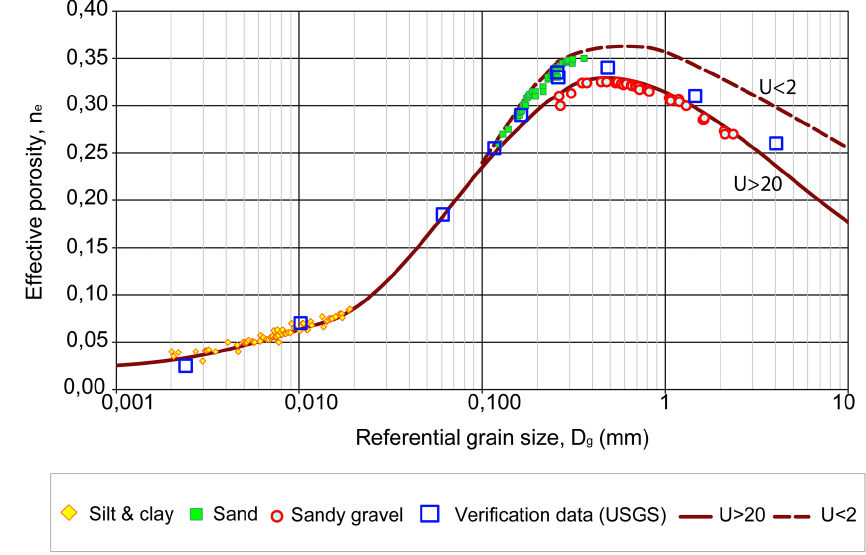
Figure 5. Relation between referential mean grain D g and effective porosity n e . Note: dotted line divides uniform grain deposits U = D 60 /D 10<2 and medium uniform grain deposit 2< U <20. Verified samples of non-uniform grain deposits of sand and gravel ( U >20) lie below the full